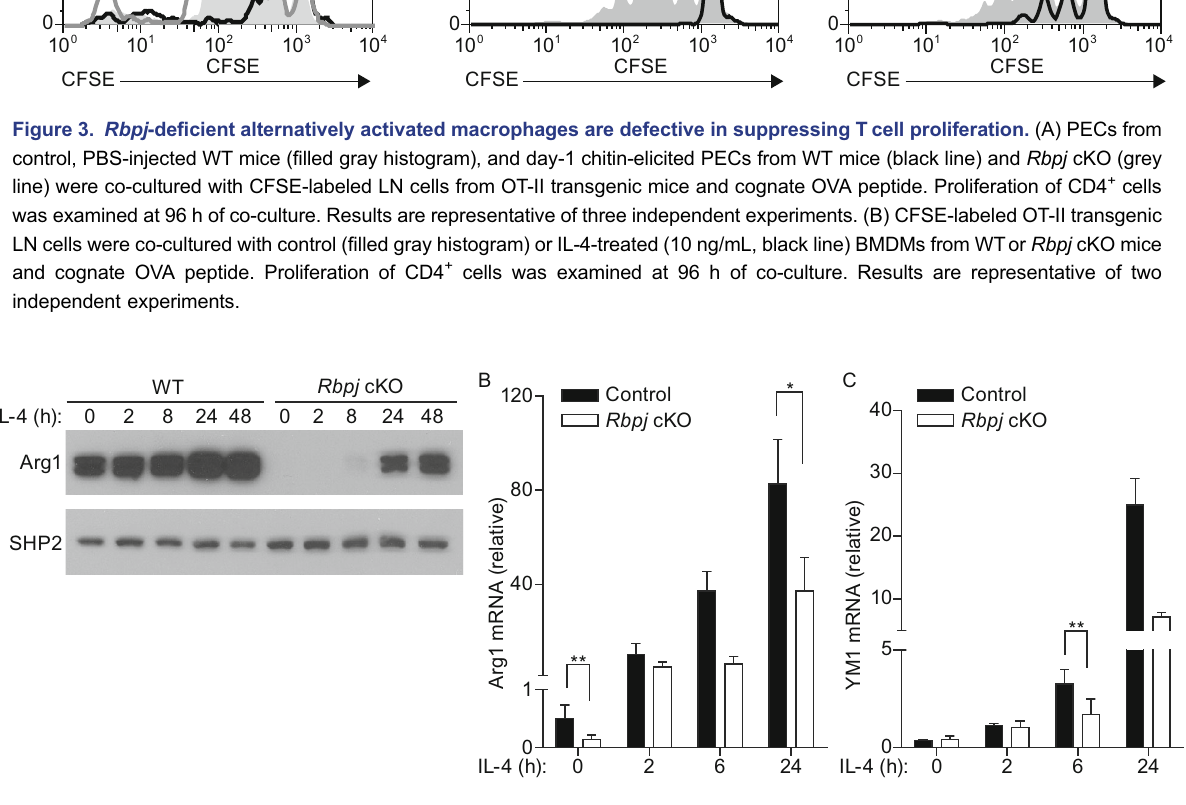
Figure 4. A crucial role for Rbpj in regulating expression of a subset of M2 macrophage genes. BMDMs from WT and Rbpj cKO mice were stimulated with IL-4 (10 ng/mL) for the indicated times. (A) Immunoblot analysis of whole cell lysates using antibodies recognizing Arg1. Levels of SHP2 served as loading controls. Results are representative of three independent experiments. (B and C) mRNA expression (relative to GAPDH mRNA) was measured using quantitative real-time PCR. Cumulative results from three independent experiments are shown (errors bars indicate s.d.). P < 0.05, ** P < 0.01 (two-tailed Student ’ s promotes M2 suppressive functions including inhibition of T cell proliferation, likely through regulation of expression of M2 effector molecules such as Arg1.